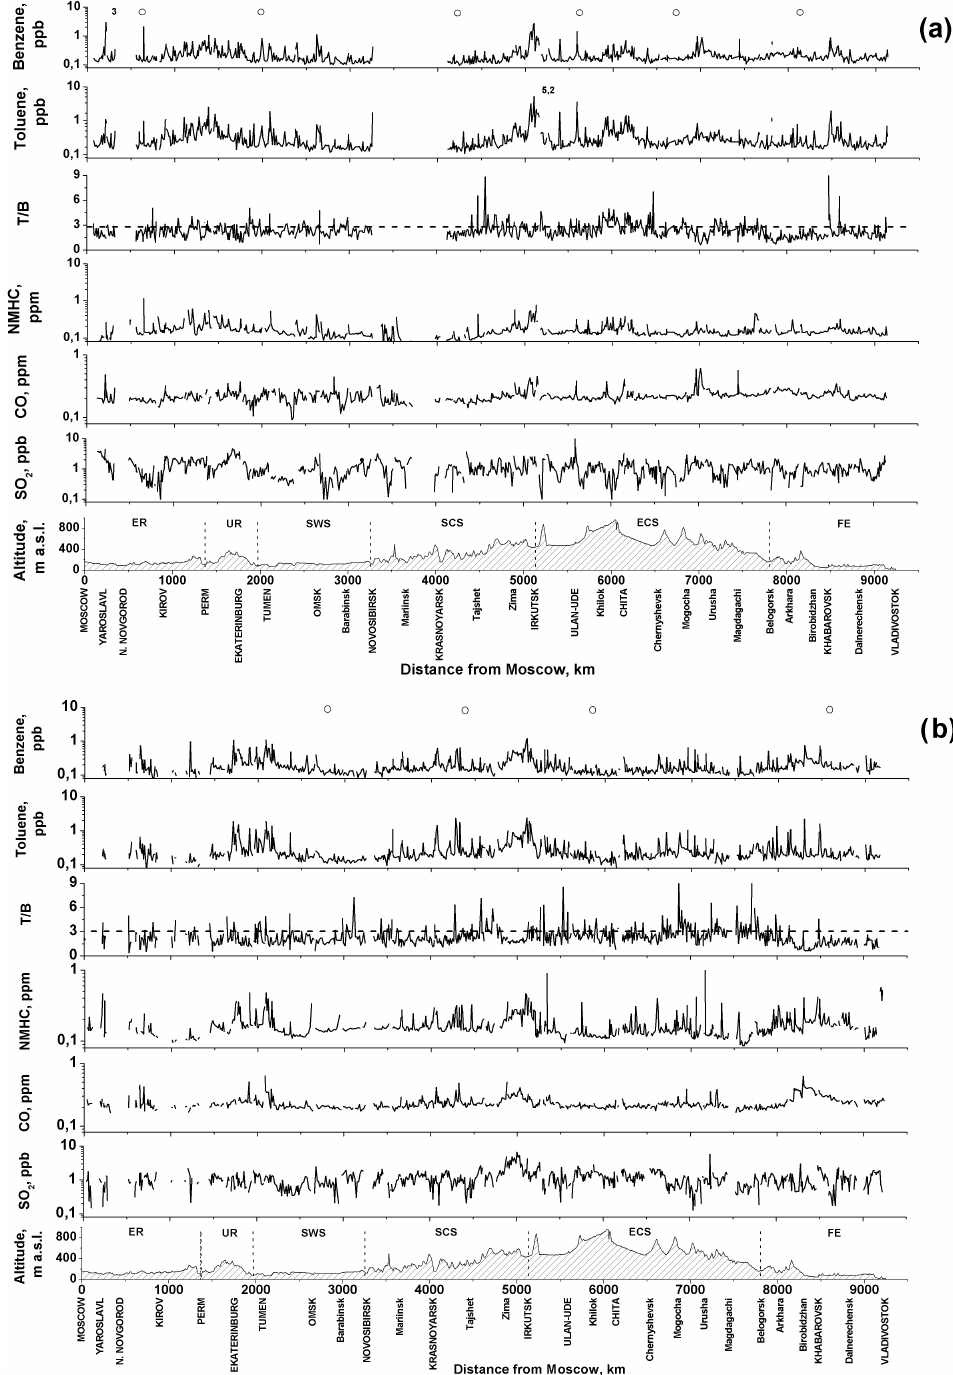
Figure 3. (a) 10min concentrations of benzene, toluene, and T / B ratio as well as NMHC, CO and SO 2 along the Trans-Siberian Railway in the east segment of the TROICA-12 campaign. Some parameters are plotted in a logarithmic scale for better data presentation. White circles on the top of the figure indicate the times of local noon. The cities with a population from 250000 to 1 million or more are shown in capital letters. A dashed line shows the T / B boundary between transport and industrial emissions (Tiwary et al., 2010; Carballo-Pat et al., 2014). (b) Same as (a) but for the west segment of the TROICA-12